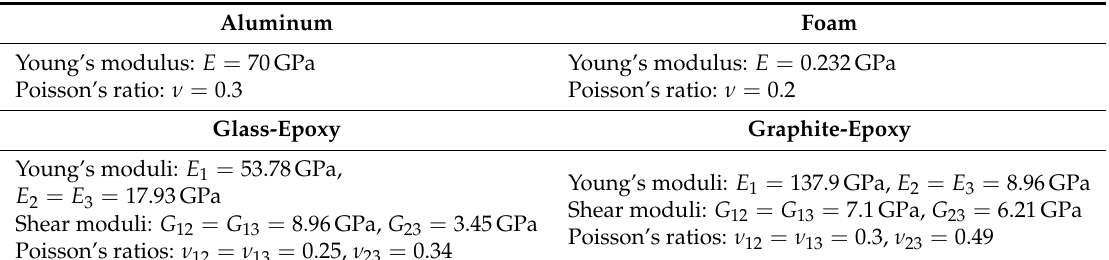
Table 4. Mechanical properties of the materials.